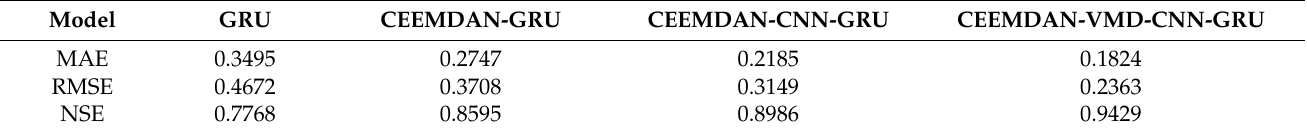
Table 3. Calculated results of different model evaluation indicators.